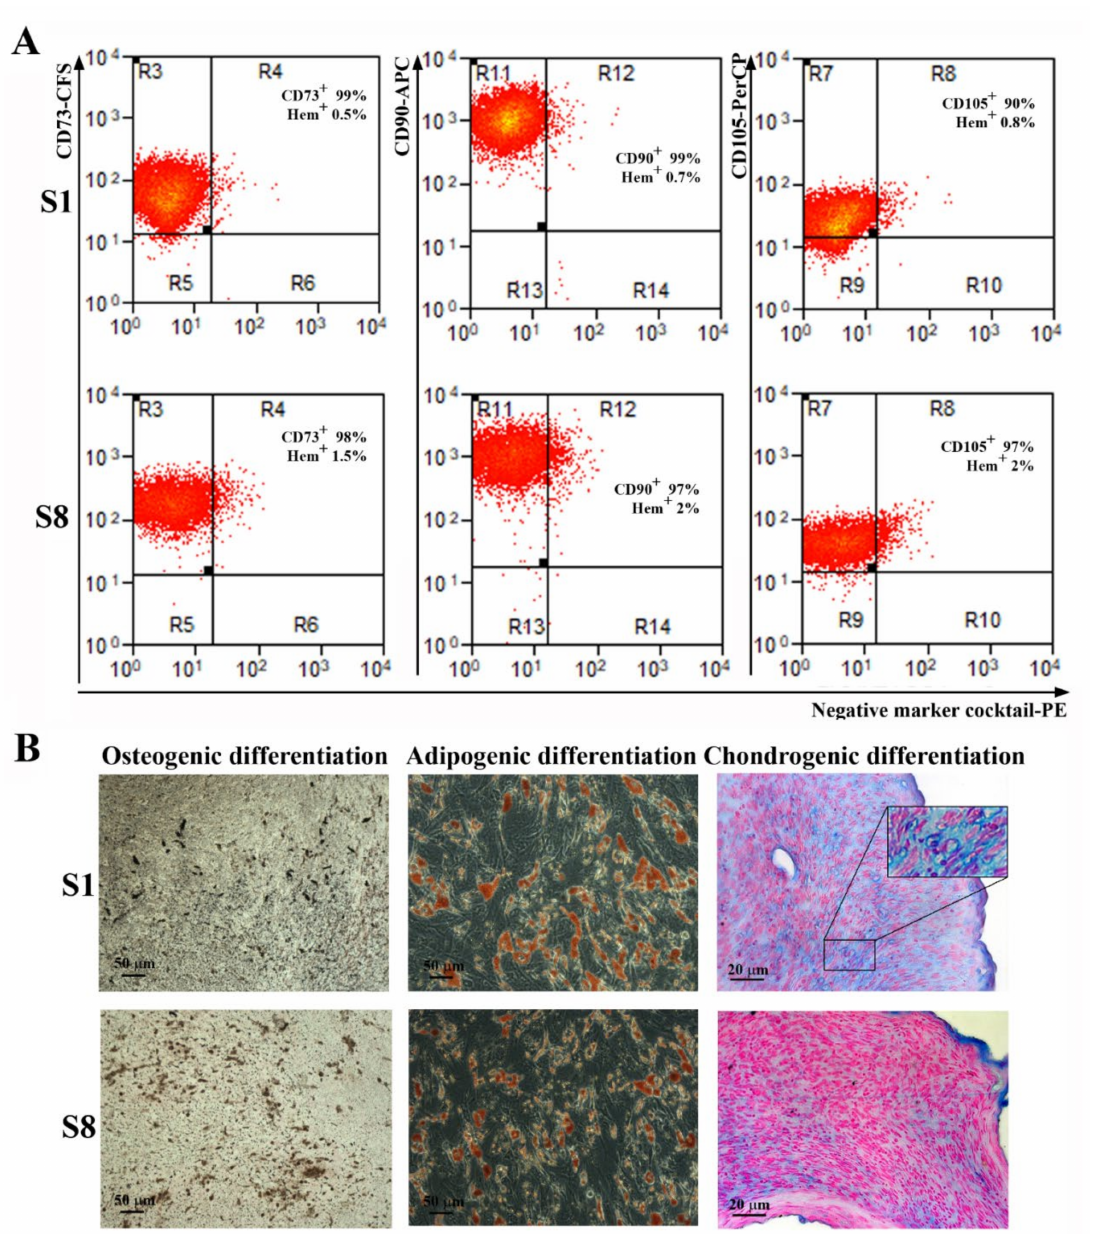
Figure 4. Analysis of surface markers expression and multilineage differentiation capacity of hTERT- transduced ADSC-derived sub-populations. ( A ) Flow cytometry histograms showing the expression of specific surface markers for MSC on sub-populations S1 and S8-ADSC at 5 passages after trans- duction. It can be noticed that the high expression for CD73, CD90, and CD105 and the absence of hematopoietic markers CD45, CD34, CD11b, CD79A, and HLA-DR were preserved after lentiviral transduction. ( B ) Analysis of the multipotent capacity of hTERT ADSC-derived sub-populations S1 and S8-ADSC by their ability to generate osteocytes (left, von Kossa staining), adipocytes (middle, Oil Red O staining), and chondrocytes (right, Alcian blue staining) when cultured in specific con- ditions. The insert in the picture of chondrogenic differentiation of S1 sub-population depicts the lacunae-containing